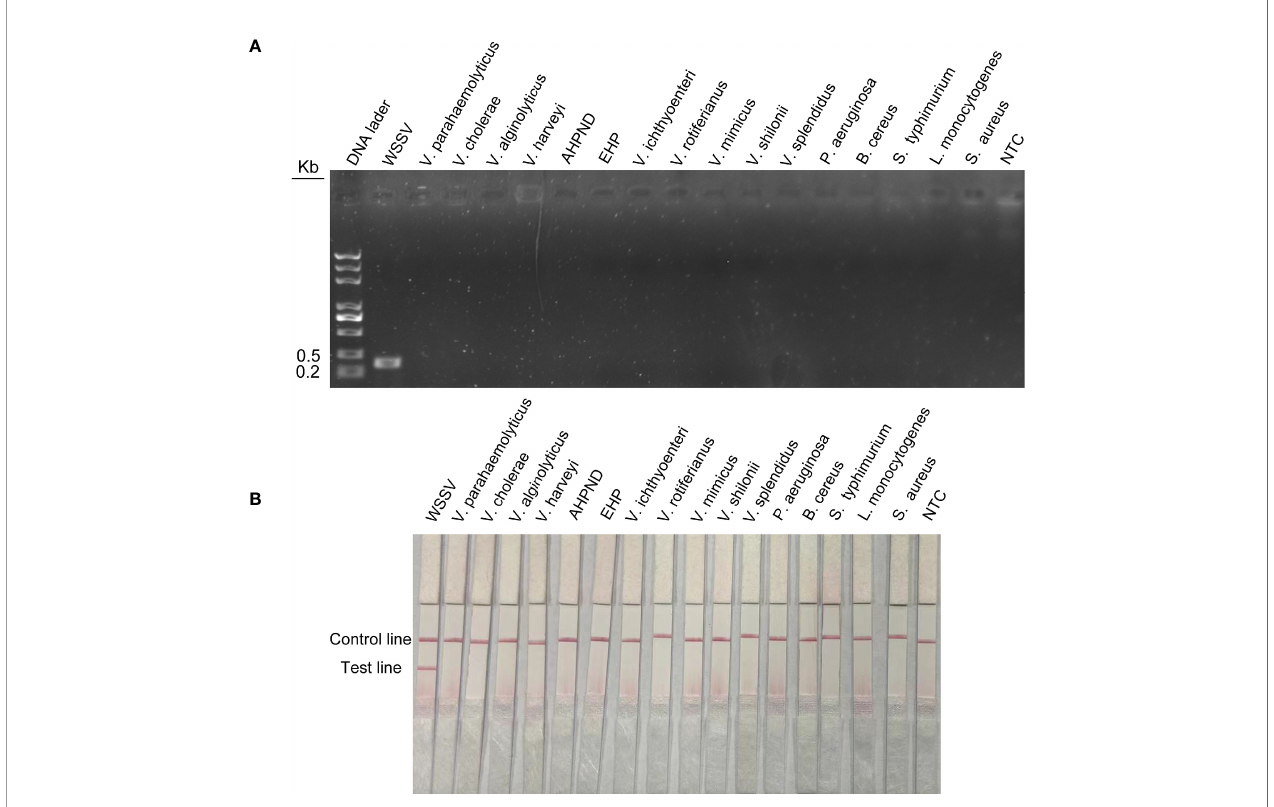
FIGURE 6 | Speci fi c detection of RPA-LFS reaction. (A) Result of RPA-ampli fi ed agarose gel electrophoresis. (B) Result of RPA-ampli fi ed LFS. Of the standard plasmid, 1 µl of 2 × 10 9 copies/ml was used as the template and reacted for 30 min at 37°C. The remaining templates are the common shrimp disease pathogens and the pathogens widely distributed in nature, which are Vibrio parahaemolyticus , Vibrio cholerae , Vibrio alginolyticus , Vibrio harveyi , AHPND, EHP, Vibrio ichthyoenteri , Vibrio rotiferianus , Vibrio mimicus , Vibrio shilonii , Vibrio splendidus , Pseudomonas aeruginosa , Bacillus cereus , Salmonella typhimurium , Listeria monocytogenes , and Staphylococcus aureus . NTC was a template-free negative control. The names of the bacterial species are shown at the top of each